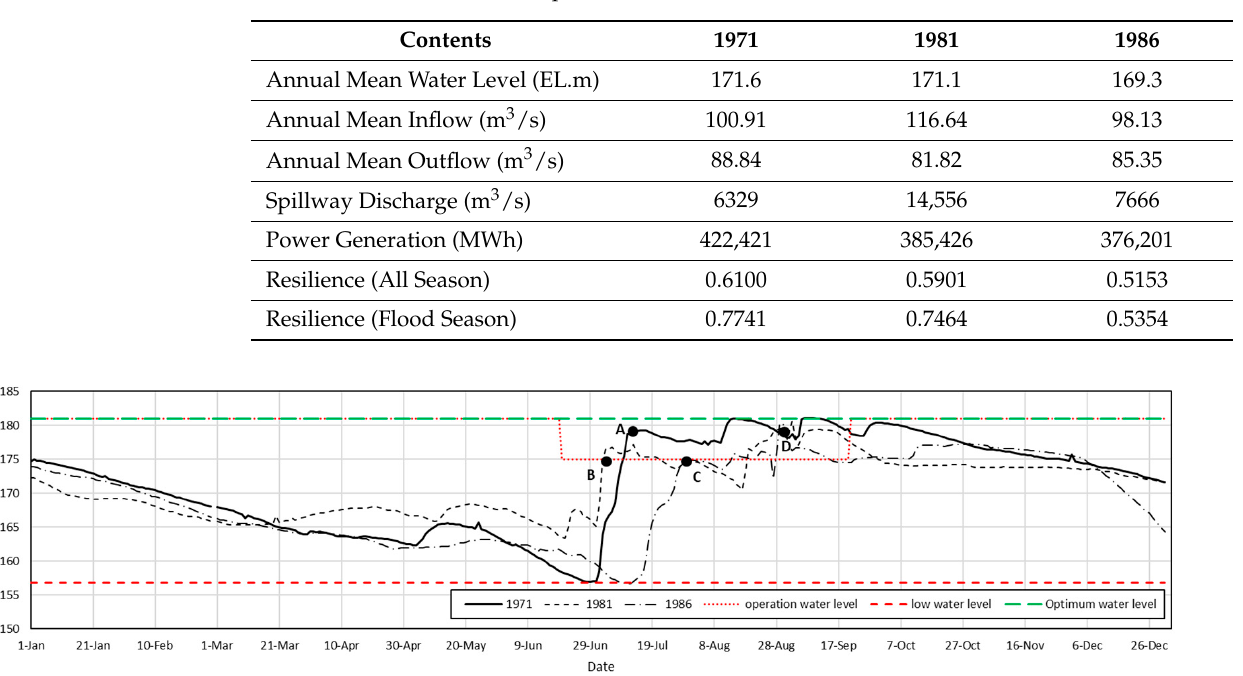
Table 2. Comparison of hydrological data and resilience (All seasons are full year and the Flood season is from 21 June to 20 September).